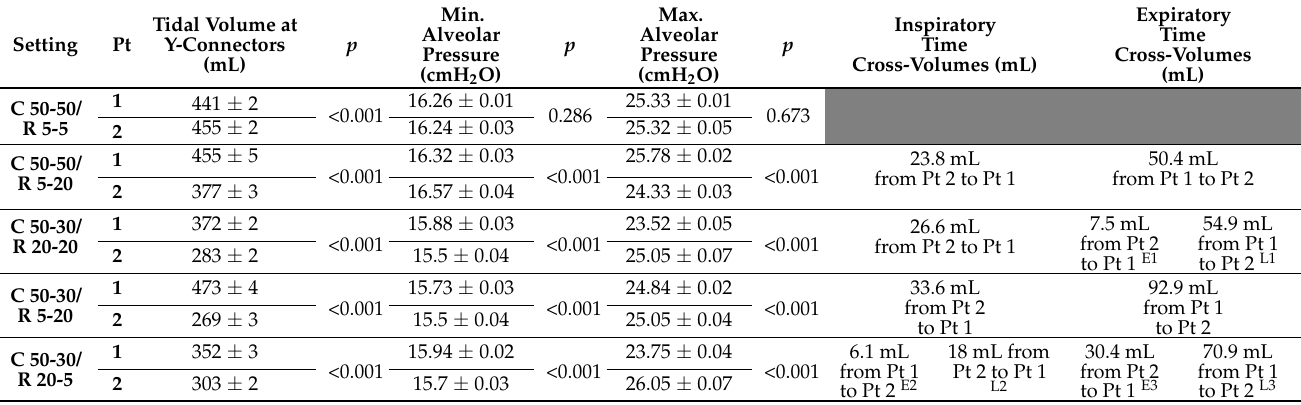
Table 2. Mean + standard deviation values of tidal volumes measured at Y-connectors of the patients, minimum and maximum values of alveolar pressures and cross-volumes between the 2 patients measured during the inspiratory and expiratory times in the 5 different settings tested in the study. p refers to t -test to compare the average values between the 2 patients. C = compliance, R = resistance, Pt = patient. E1 indicates early expiratory phase from 1.08 to 1.37 s; L1 indicates late expiratory phase from 1.37 to 3.00 s; E2 indicates early inspiratory phase from 0.00 to 0.26 s; L2 indicates late inspiratory phase from 0.26 to 1.07 s; E3 indicates early expiratory from 1.07 to 1.49 s; L3 indicates late expiratory phase from 1.49 to 3.00 s. Grey cells indicates negligible cross-volume